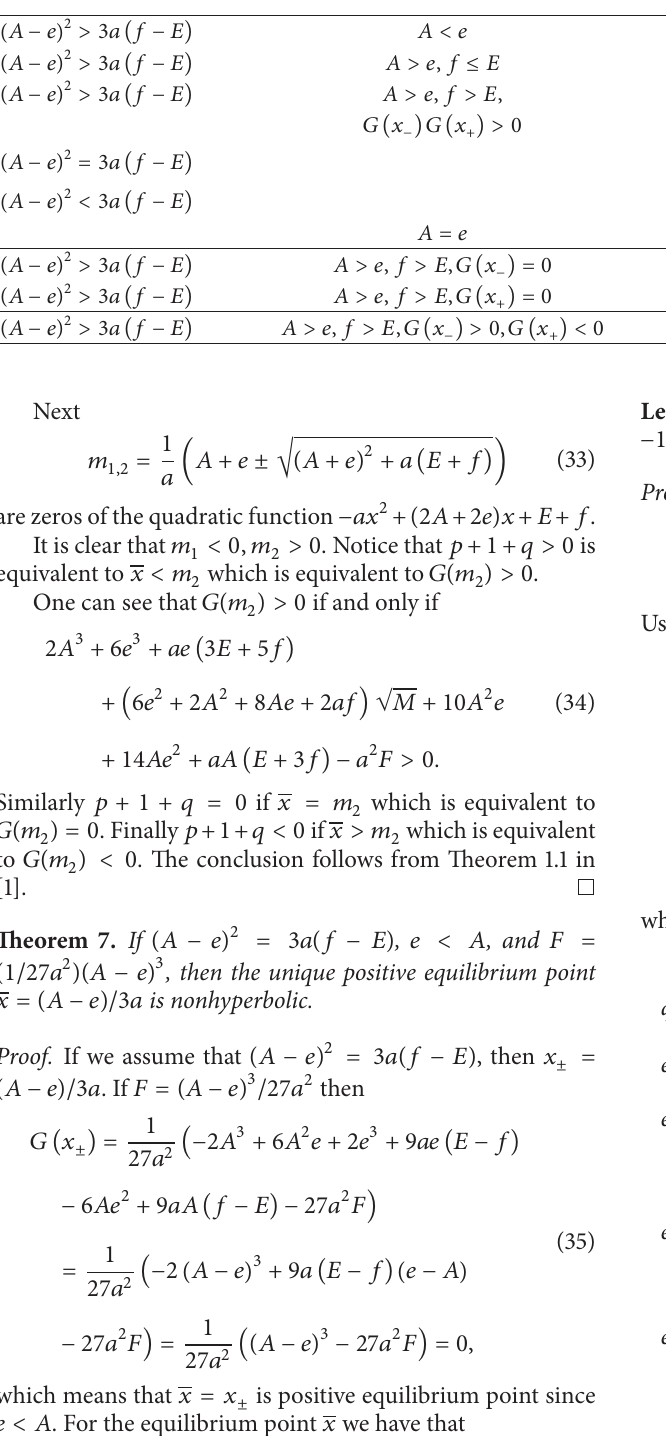
Table 1: Existence of the positive equilibrium points of (1) when 𝐹 > 0